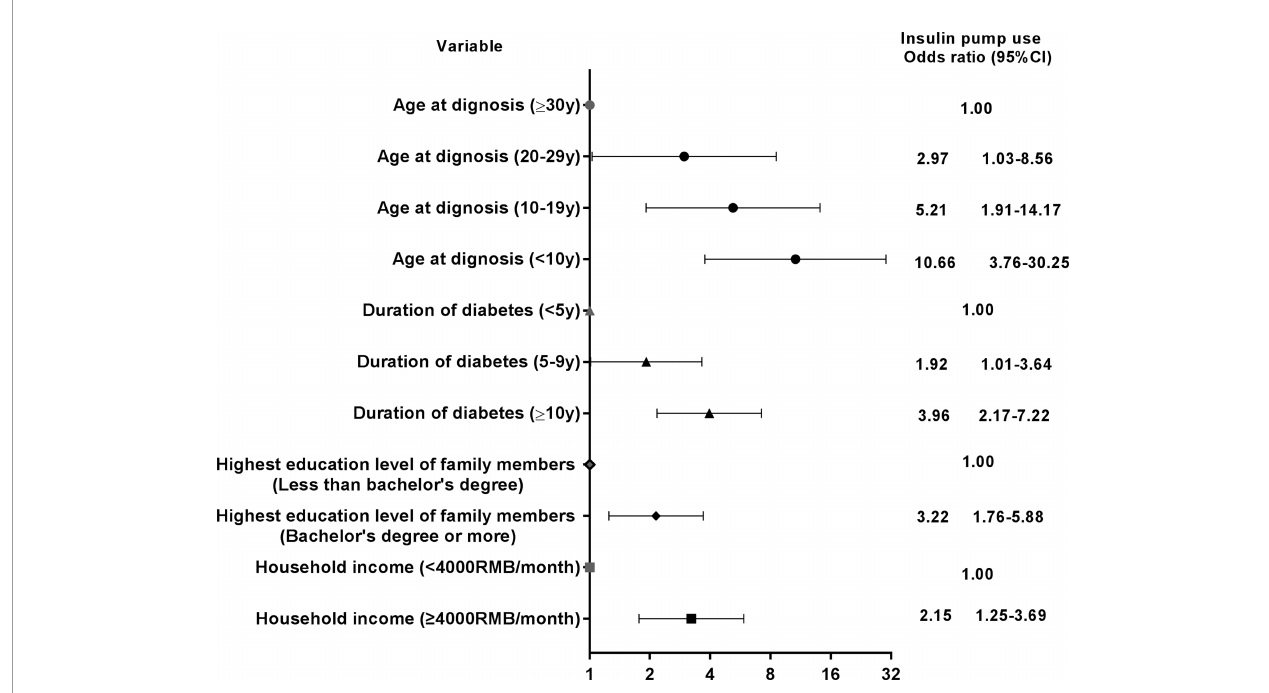
FIGURE 2 | Adjusted odds ratios and 95% con fi dence interval (CI) between insulin pump use and different patient characteristics. Variables introduced in the multivariable analysis were age, sex, age at diagnosis, duration of diabetes, waist circumference, household income, location of residence, education level of family members and insurance